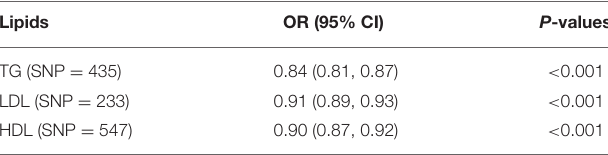
TABLE 2 | Associations based on multivariable MR (IVW) between genetically predicted circulating lipids and vitamin D levels. Lipids